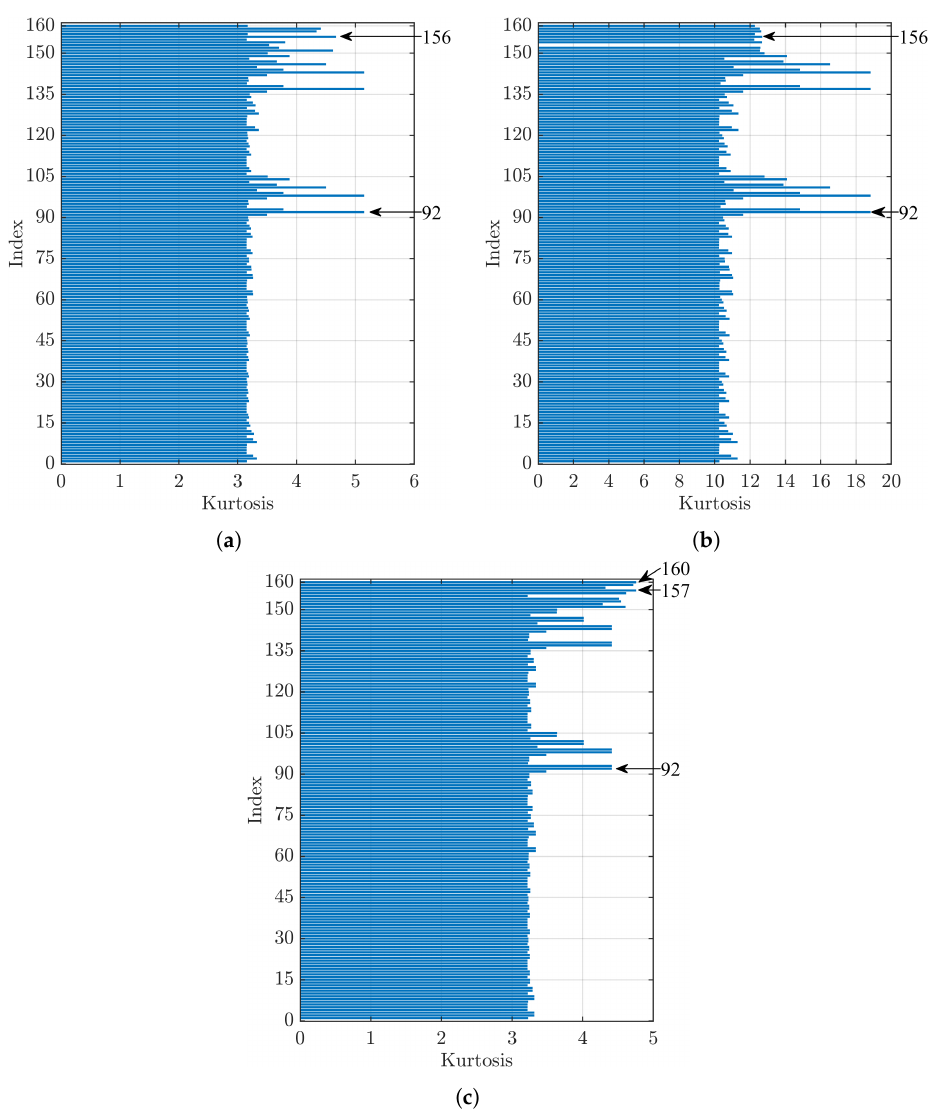
Figure 10. Comparison of kurtosis values for a bearing with a defect on the rolling element (B) of diameter: ( a ) 0.007 in, ( b ) 0.014 in, and ( c ) 0.021